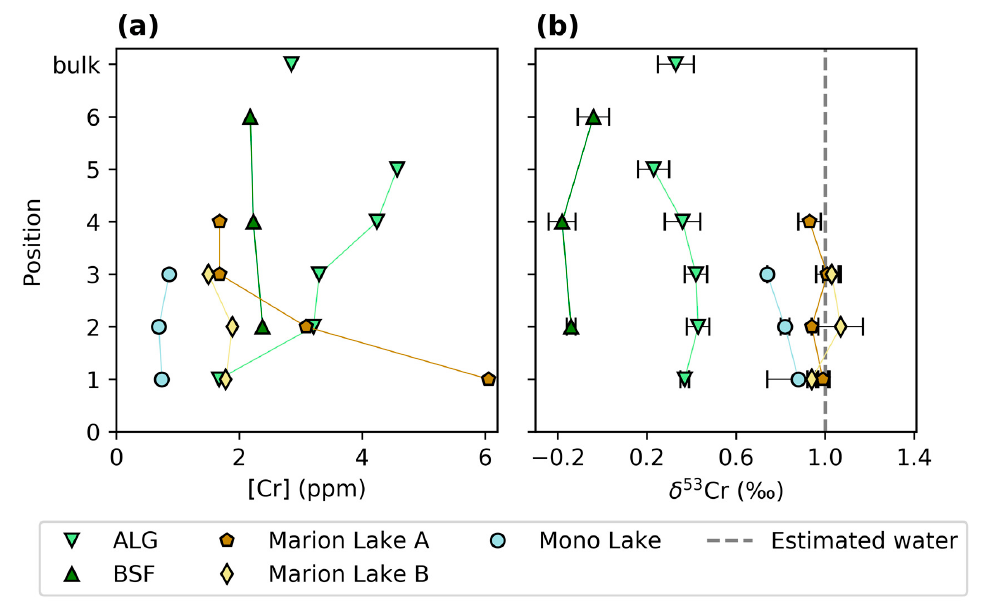
Figure 3. Cr concentrations ( a ) and isotope compositions ( b ) of microbialites and the estimated Marion Lake water samples (dashed grey line). Numbers on y-axis indicate the sample position (see Figure 1 and Table 1).